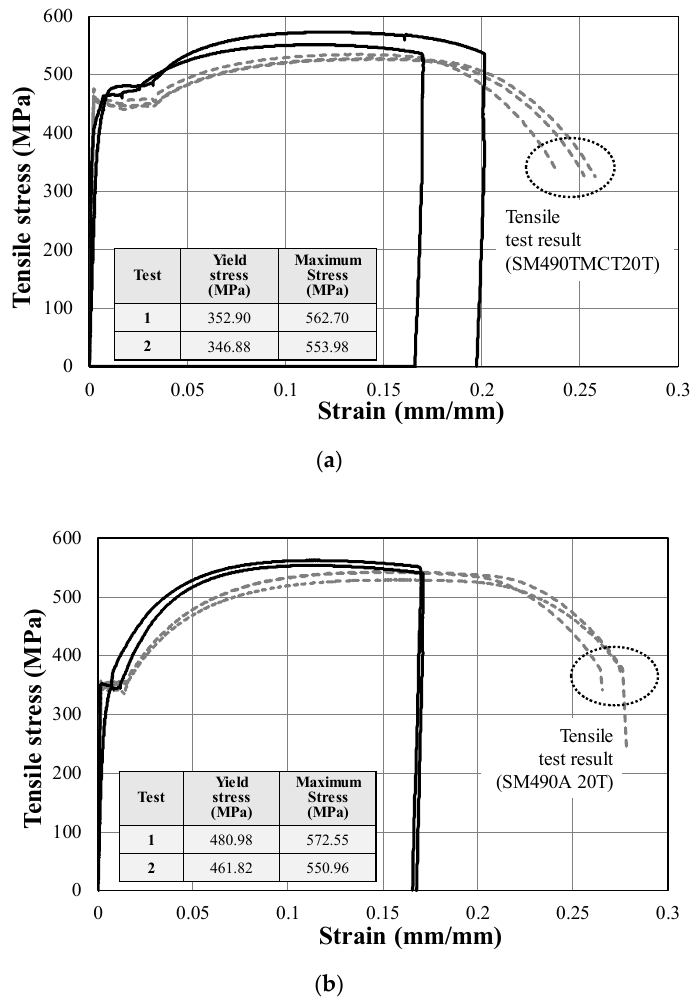
Figure 6. Result of direct tensile test at welding joint. ( a ) SM490TMC-30T and SM490TMC-20T; ( b ) SM490TMC-30T and SM490A-20T.